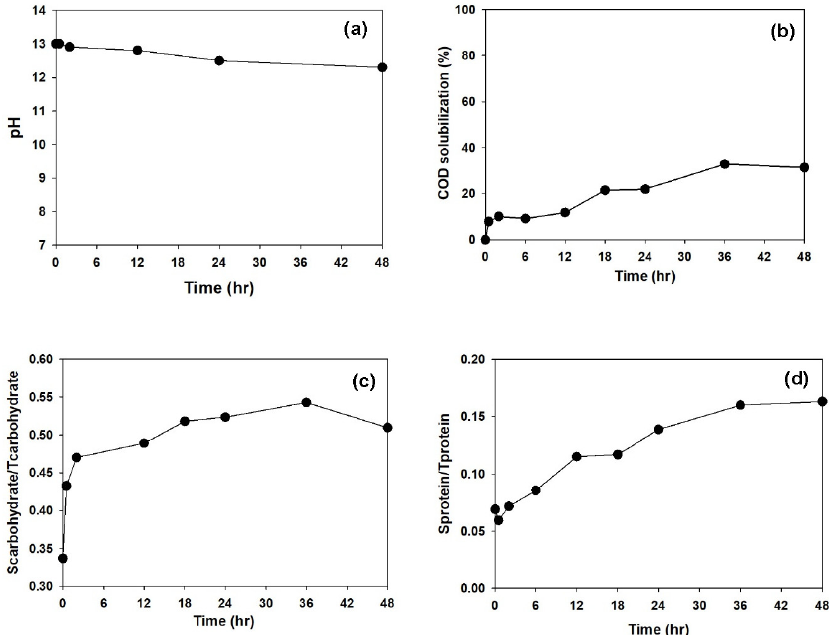
Figure 2. Solubilization of food waste: ( a ) pH variation, ( b ) COD solubilization, ( c ) soluble carbohy- drate/total carbohydrate, and ( d ) soluble protein/total protein.